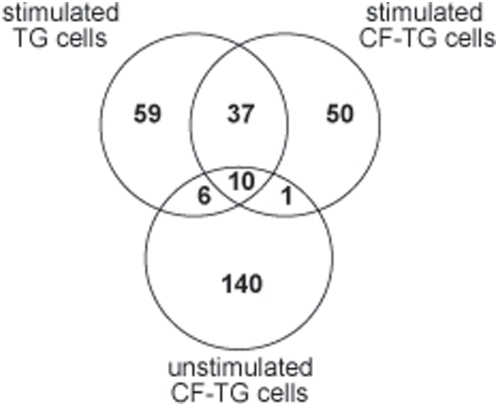
Venn diagram of differentially gene expression.A total of 157 modulated genes in CF-TG cells, 111 in wt TG cells stimulated with P. aeruginosa-secreted products and 98 in CF-TG cells stimulated with P. aeruginosa products were compared. Intersection showed 46 genes modulated within wt TG and CF-TG cells stimulated with P. aeruginosa-secreted products, and 10 genes were common in the three groups of cells.